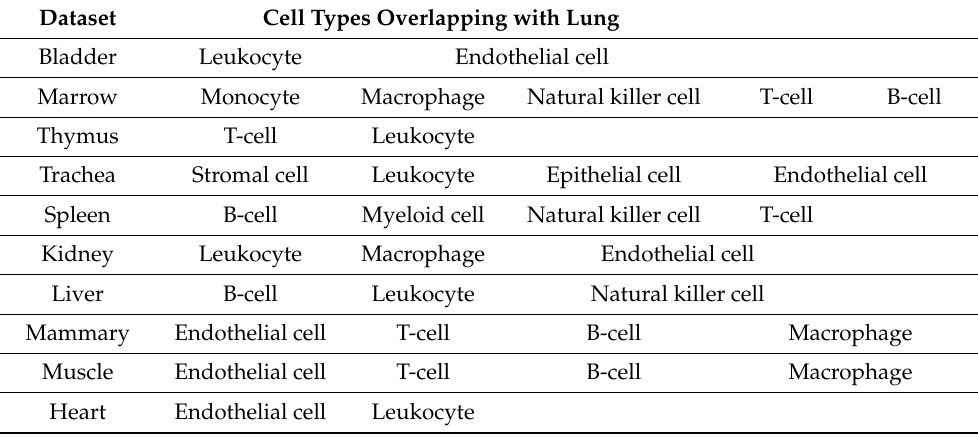
Table 4. Cell types from Lung samples integrated from SMART-seq2 and 10x genomics, also present in other combined